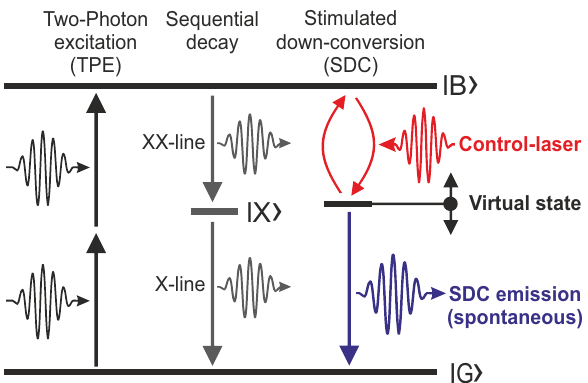
Fig. 2 Stark shift behavior of the SDC-emission. a A control-laser energy higher than the TPE laser energy results in SDC-emission from j B i to the virtual state at E = E G + E C . b A control-laser energy lower than the TPE laser energy results in SDC emission from the virtual state at E = E B − E C to j G i . In both cases the Stark-shift of the SDC emission is given by the Stark- shift of the j B i